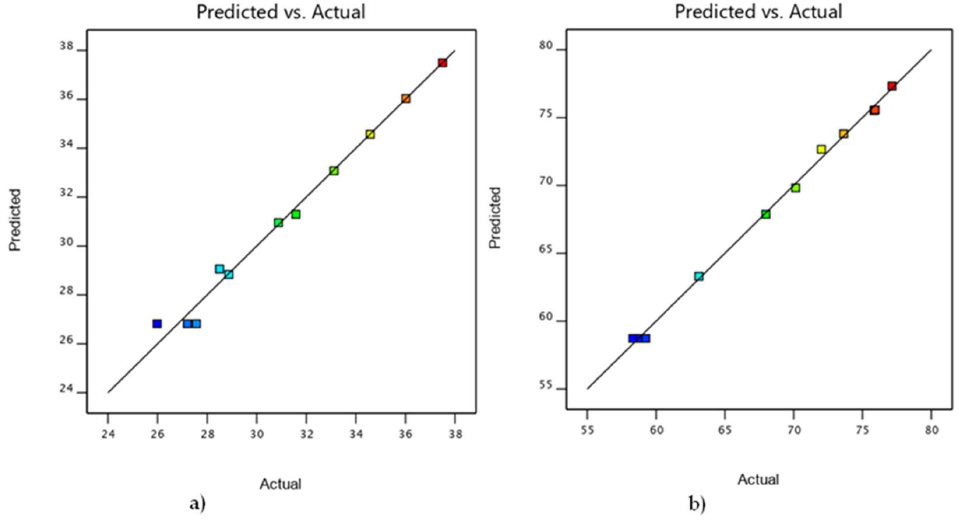
Figure 10. Relation between experimental and model predictions for ( a ) crystal size, ( b ) crystallinity responses. Figure 11 indicates the optimal region. Under optimal conditions (HAp 0.726/BG 0.274, temperature 180 °C), nanocomposites with the highest degree of crystallinity (79.08%) and the smallest size (33.49 nm) were obtained.